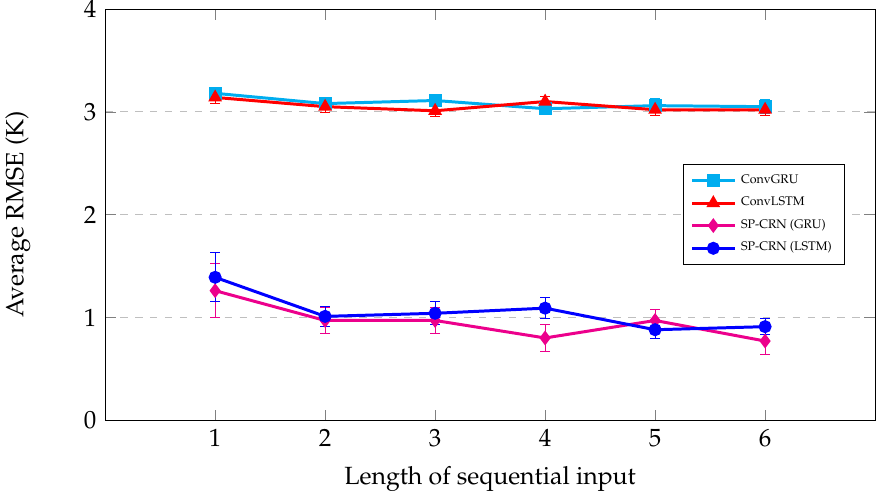
Figure 9. The average RMSE of comparison methods of different lengths of sequential input for SST prediction. The error bar indicates the SD of the